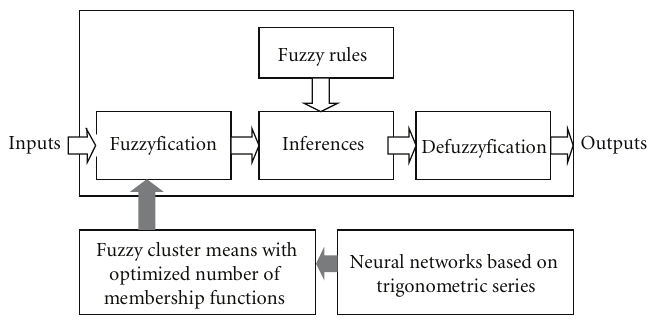
Figure 1: Proposed neuro-fuzzy controller [4].